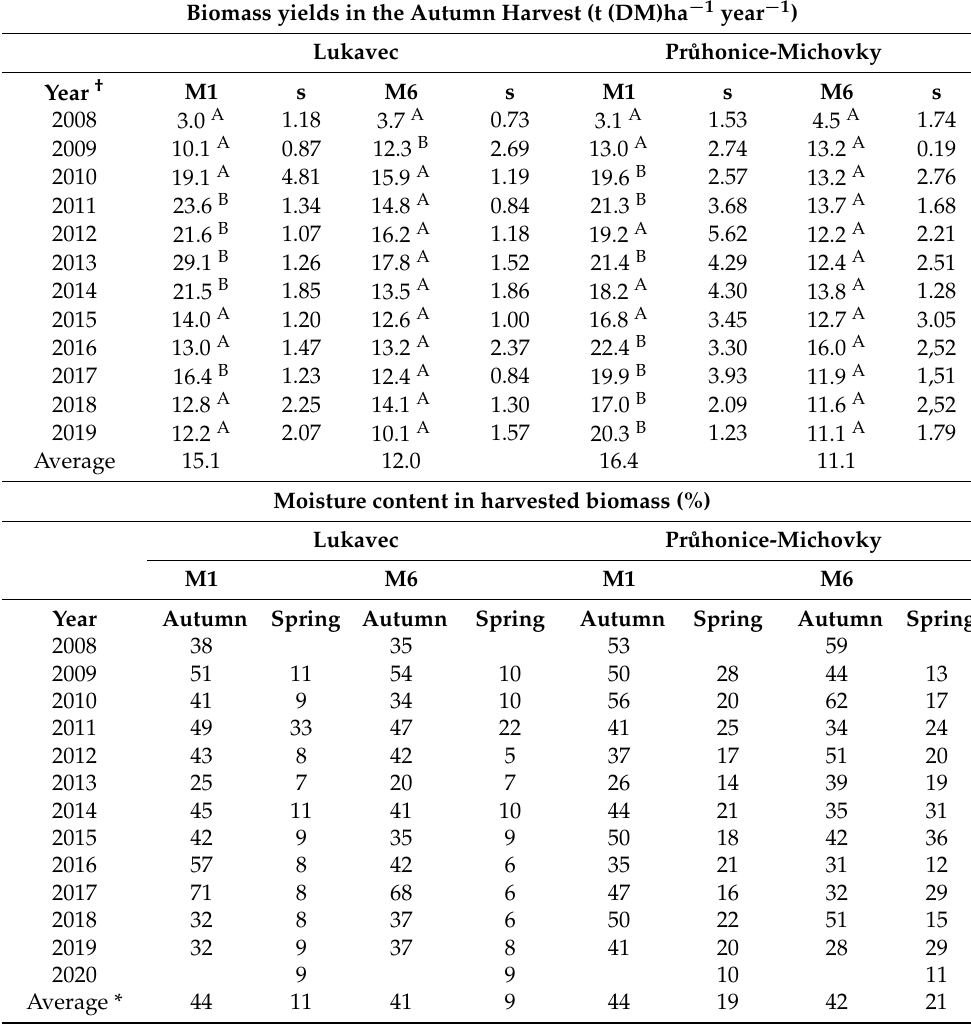
Table legend: s—standard deviation; † years are considered as financial years (I-XII); * average yields from 12 harvests are calculated for 13 years of the experiment; A–B indexed capital letters show results of statistical analysis of yields (MANOVA–Duncan; homogenous groups) in individual years and